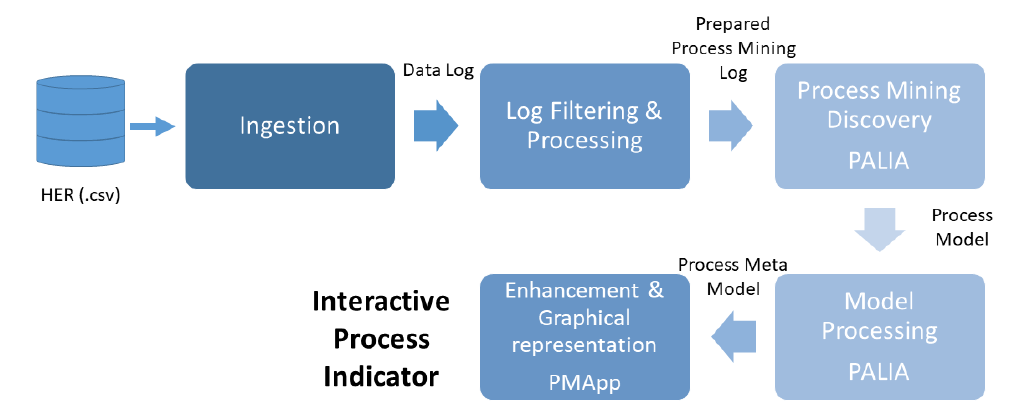
Figure 1. Methodology